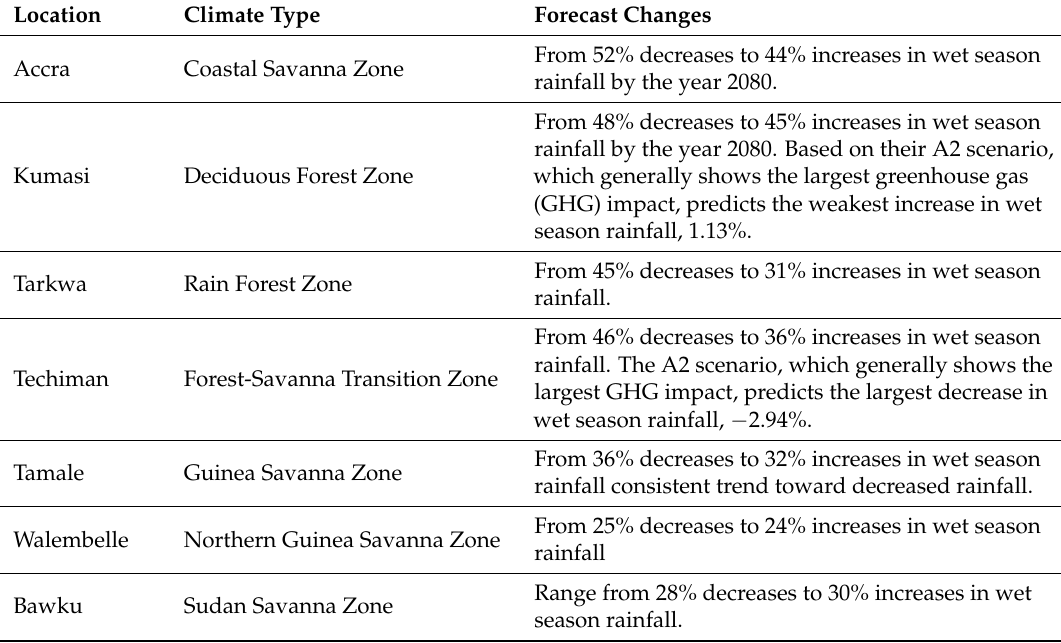
Table 1. The projections of precipitation in Ghana.